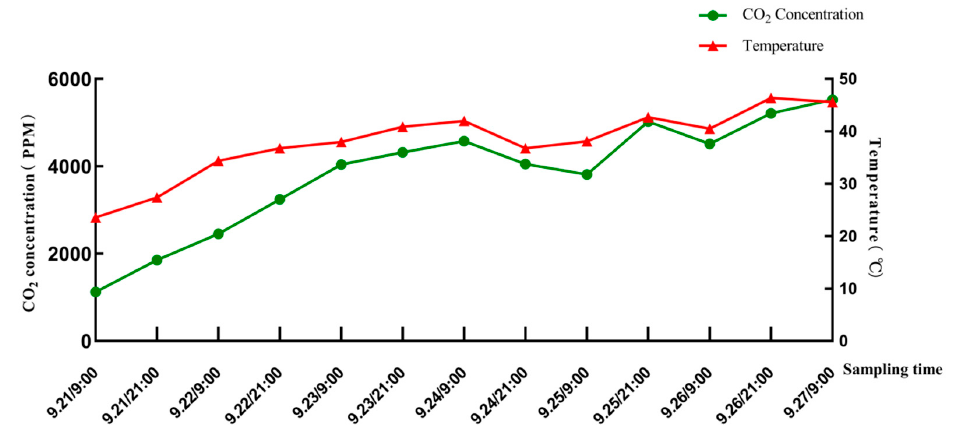
Figure 5. Curves of the temperature and CO 2 concentration of a rice plant stack. In addition to the increase in CO 2 concentration and temperature, stacking rice plants in open air makes them prone to mildew and causes changes in the cracking rate of the grains. As shown in Figure 6, at 21:00 on 25 September (the fourth day of rice plant stacking), the cracking rate of plants in the upper layer of the grain pile rose rap- idly due to the large temperature difference between day and night, dew on the surface of the grain pile in the morning, sun exposure at noon, and cloudy and rainy weather, affecting the quality of the rice.